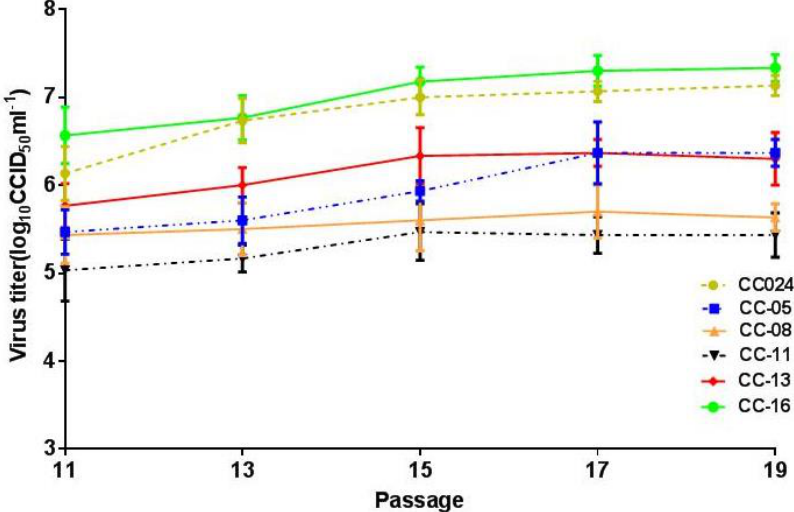
Figure 4. Growth curves of CC024, CC-05, CC-08, CC-11, CC-13 and CC-16 strains during passage in Vero cells infected at the MOI of 0.01. The titer of the CC-16 strain (10 7.2 CCID 50 /mL) was the highest at 96 h post-infection.